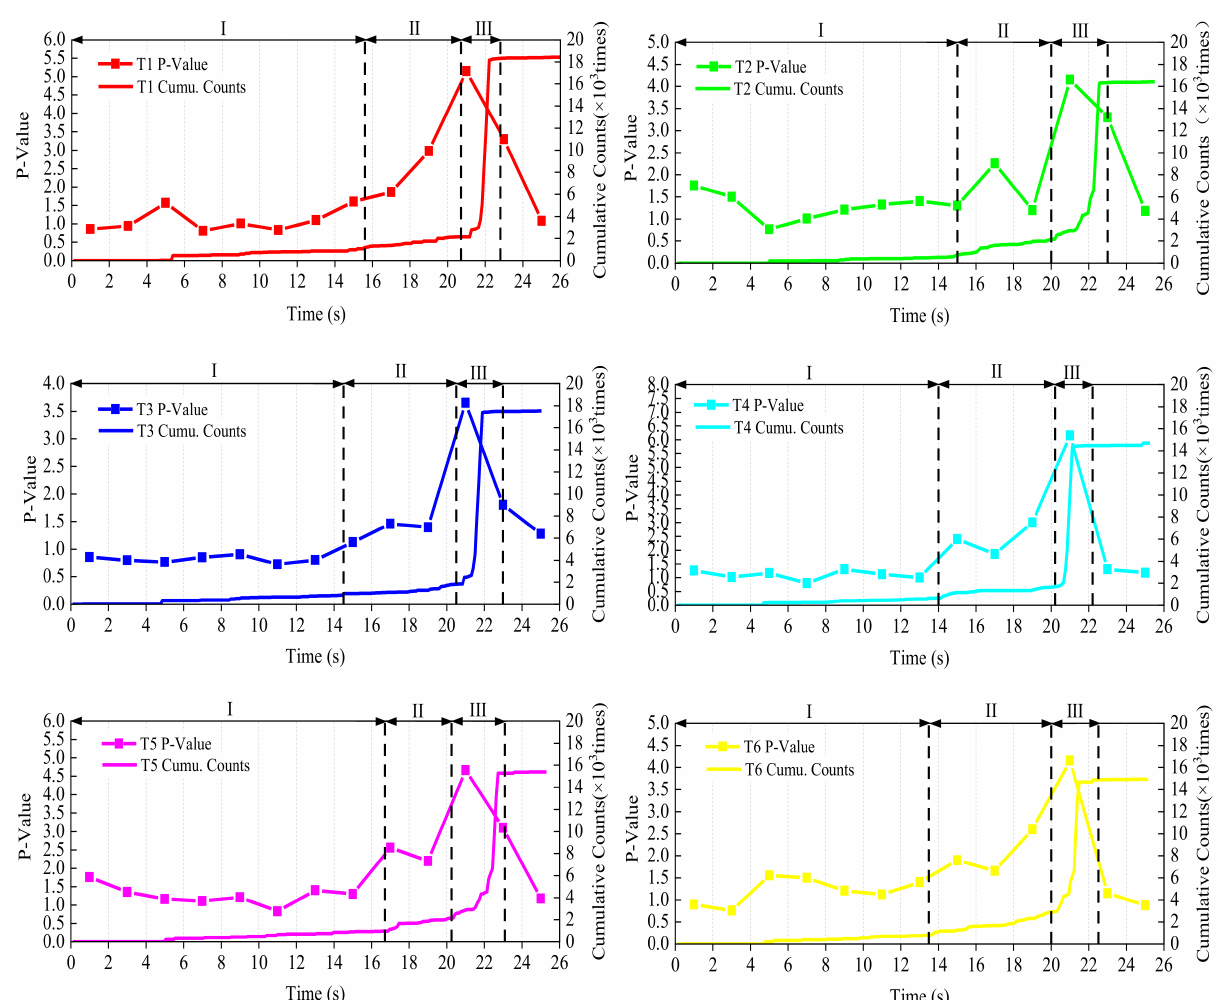
Figure 9. The peakedness (P) variation during the